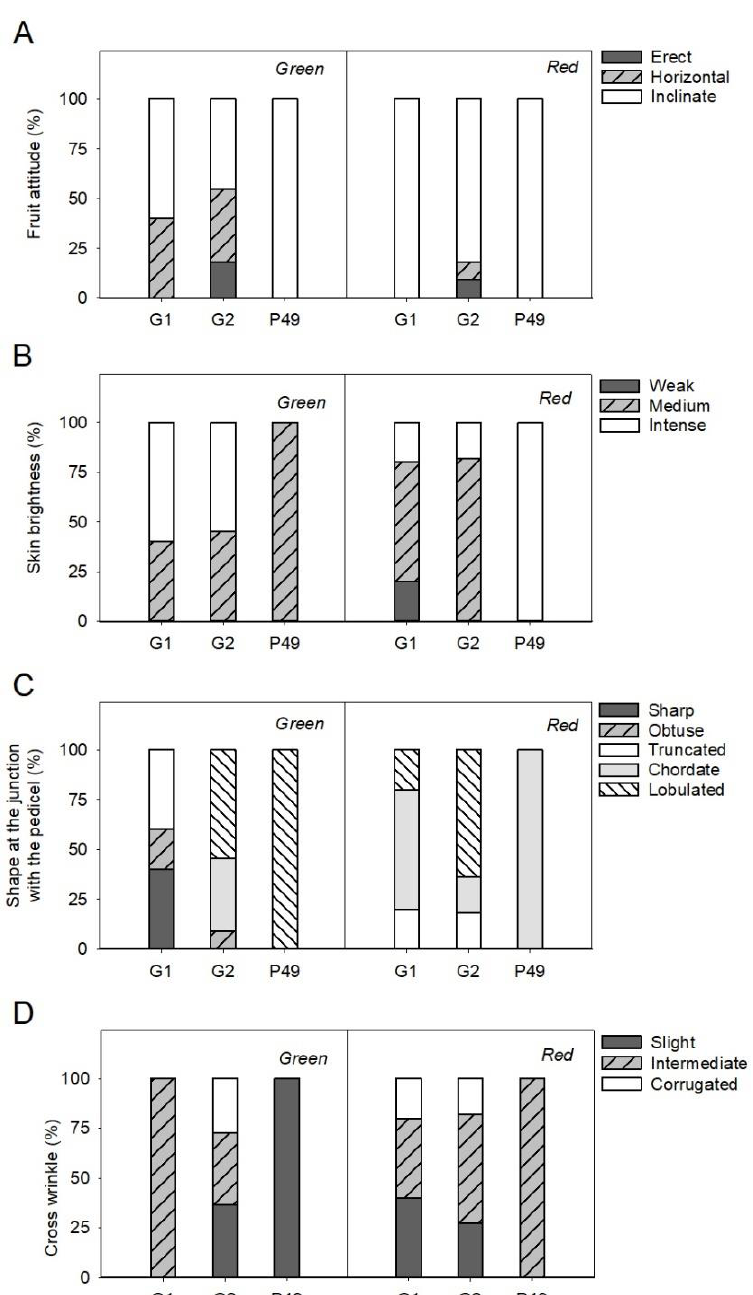
Figure 6. Frequency distribution of the selected fruit qualitative traits in the 17 pepper landraces in two ripening stages (green and red); ( A ) fruit attitude, ( B ) skin brightness, ( C ) shape at the junction with the pedicel, ( D ) cross wrinkle. The mean value for each landrace was represented by the most frequent representation of the trait after classifying the independent fruit samples ( n = 10) according to the scale (Table S1).